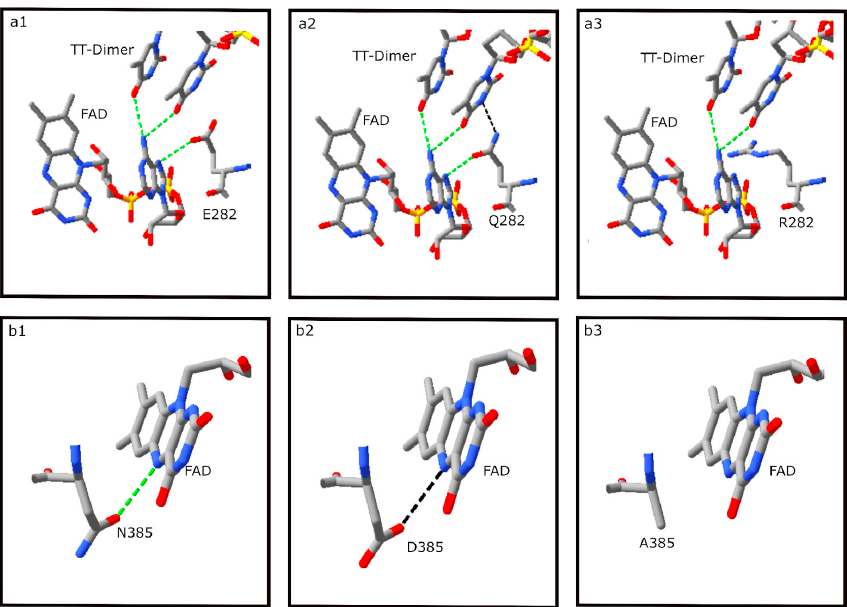
Figure 7. Analysis using Swiss-Pdb Viewer of interactions of natural or substituted amino acids at positions 282 and 385 of SEL photolyase with bound DNA or FAD cofactor. ( a1 ) E282 in SEL showing H-bond formation between E and FAD (green dashed lines); ( a2 ) E282Q substitution in NRC-1 showing H-bonds (green dashed lines) between Q and FAD, and a weaker H-bond (black dashed line) between Q and the TT-Dimer; ( a3 ) E282R substitution in BOL5-1 showing no H-bond formation between R and FAD/TT-Dimer; ( b1 ) N385 in SEL showing an H-bond formation between N and FAD (green dashed line); ( b2 ) N385D substitution in BOL6-1 showing a weak H-bond (black dashed line) between Q and FAD; ( b3 ) substitution N385A in BOL5-1 showing no H-bond formation between R and FAD.